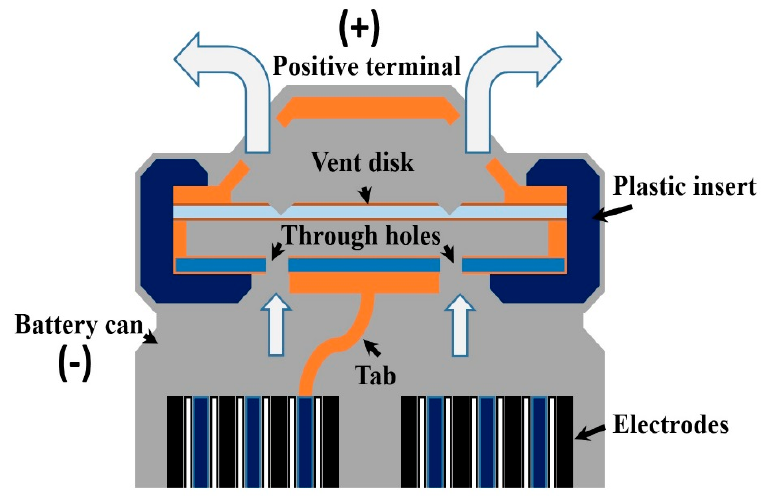
Figure 1. The typical structure of the 18650 battery cap. If the vent function works well during the thermal runaway process, the vent disk will break at the scoring and form a pathway to the internal gases.